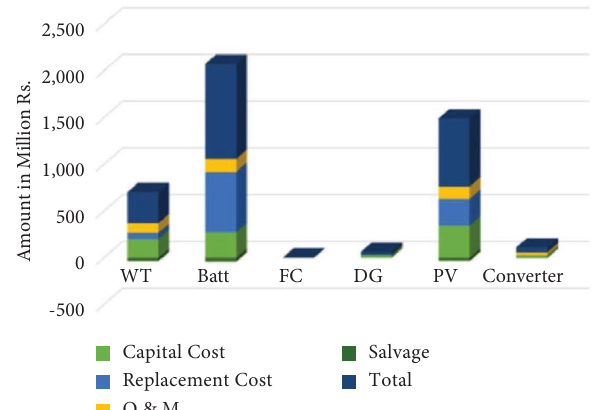
Figure 11: Net cost summary of the component.